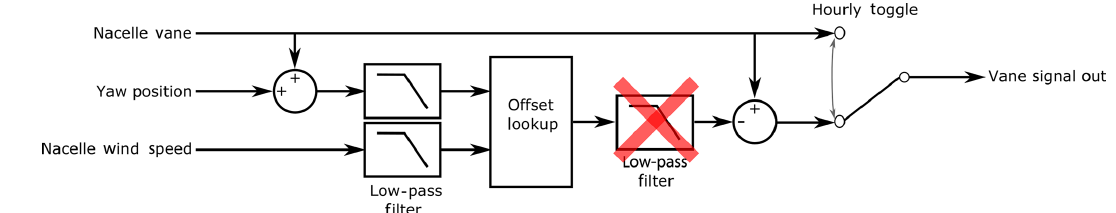
Figure 3. Wake-steering controller used in the study. As in Phase 1, the controller produces an offset wind vane signal to be passed to the yaw controller. In Phase 2, the filter at the lookup table output was removed.